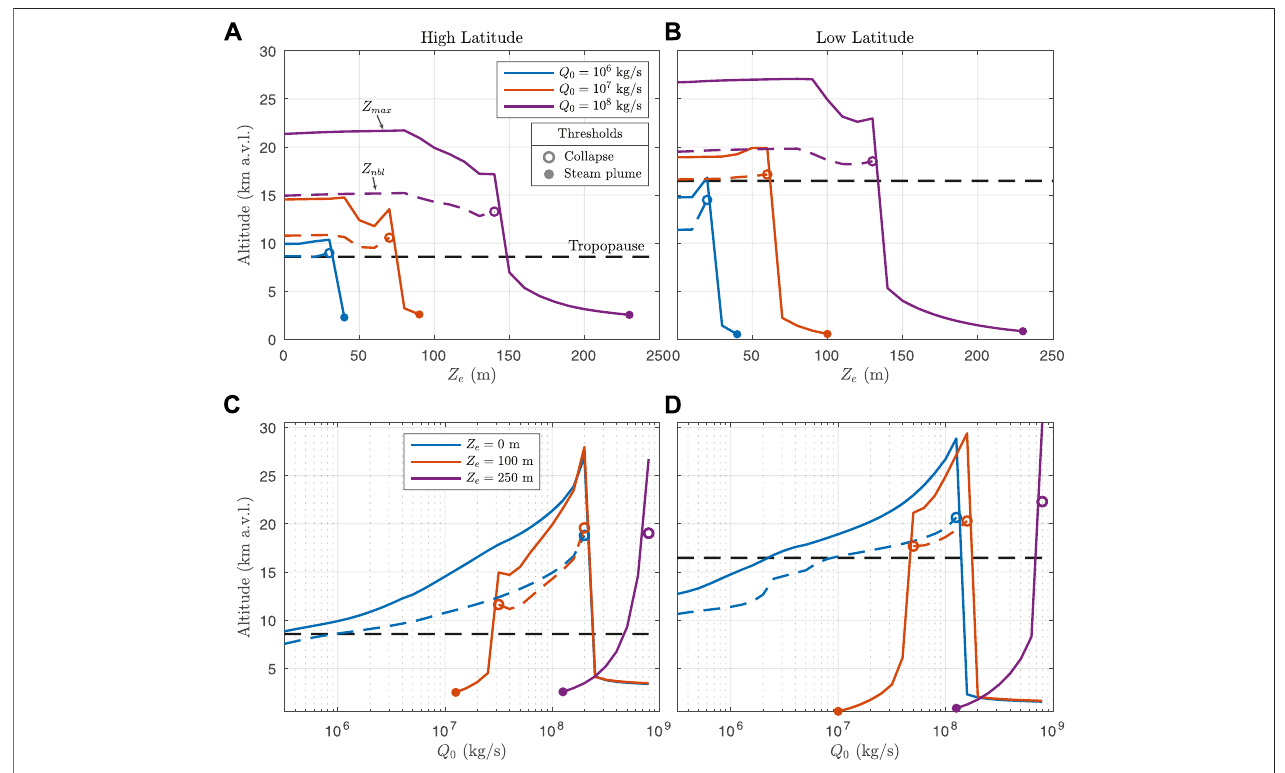
FIGURE 10 | Eruption column height (above vent level) versus (A,B) surface water depth for three control values of MER and (C,D) MER for three fi xed values of water depth. Left column plots (A,C) are for high latitude and right column (B,D) for low latitude atmospheres. For all plots, solid lines denote maximum column height, Z max , dashed lines are height ofneutral buoyancy, Z nbl , open circles indicate thresholdvaluesfor column collapse, and closed circles indicate thresholdvaluesfor steam plumes at the water surface.